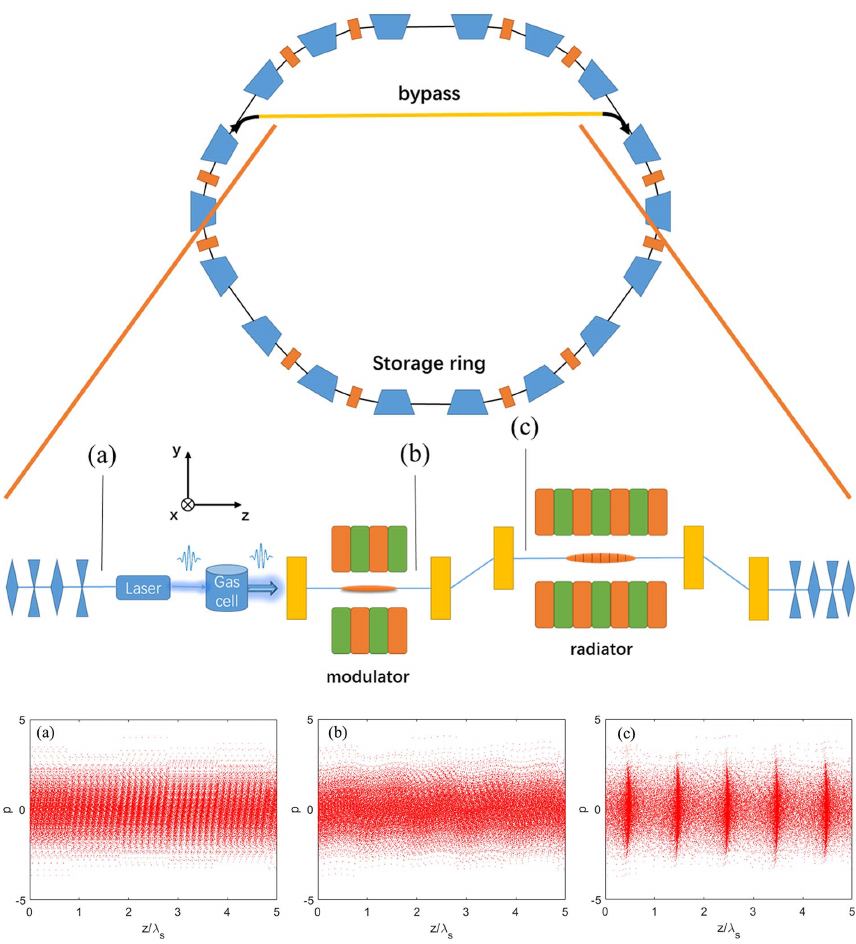
Figure 1 Schematic layout of a storage ring with a bypass line showing the proposed technique and the longitudinal phase space evolution: ( a ) the initial phase space; ( b ) the phase space at the entrance of the dispersion section; ( c ) the phase space at the exit of the dispersion